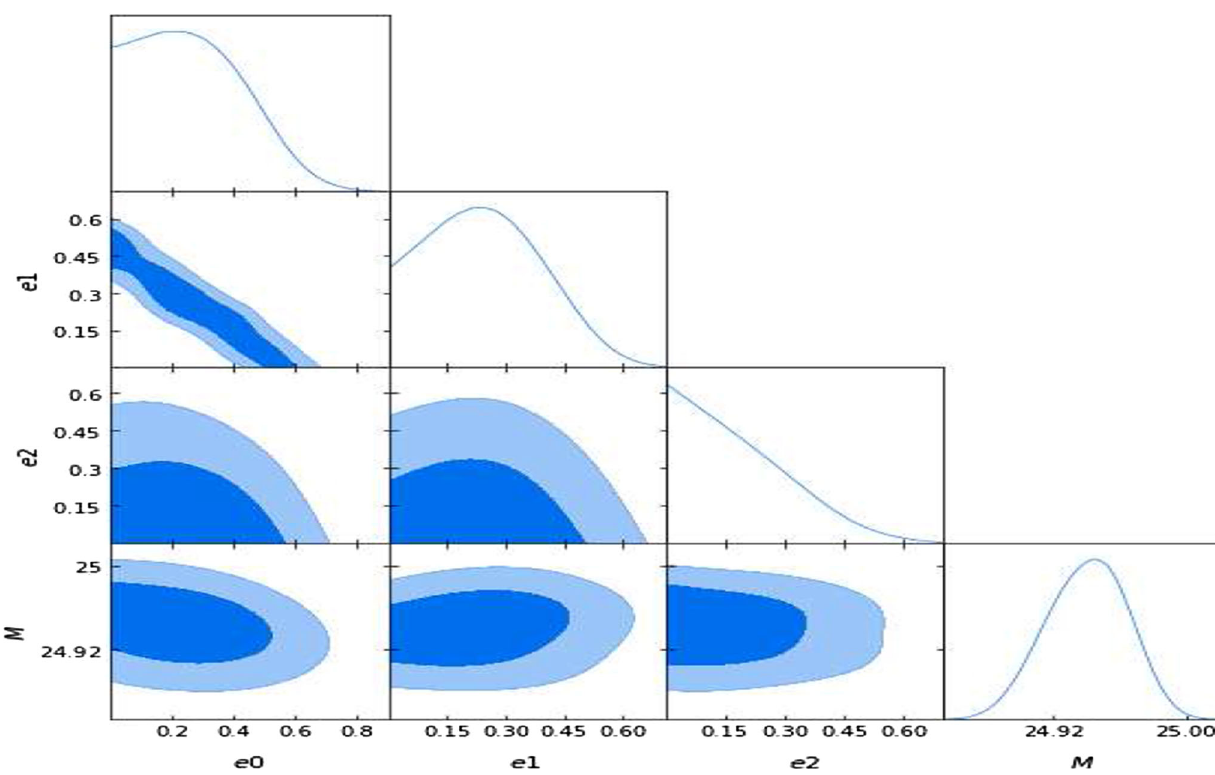
Fig. 1 Thecontourmapofmattercreationmodelusingdatafrom SNe withmarginalizedprobabilityfortheparameters.Theassociated1 σ( 68 . 3% ) and 2 σ( 95 . 4% ) confidence contours are shown. In Fig. the symbols e 0, e 1 and e 2 denote the model parameters α , β and γ , respectively